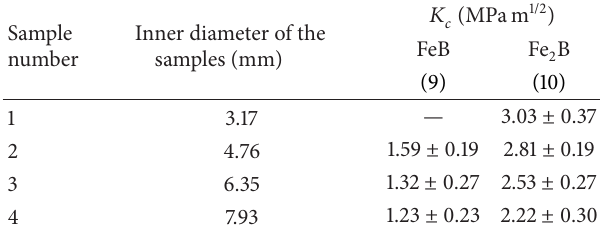
Table 5: 𝐾 𝑐 values for the FeB and Fe boron potential represented by the inner diameter of the